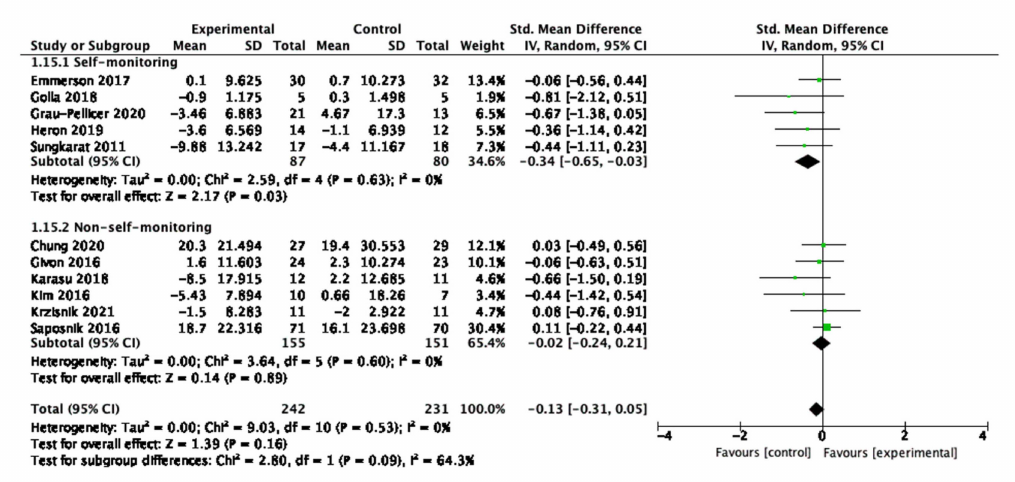
Figure 14. Subgroup analysis for self-monitoring of digital interventions that measured sedentary behaviour